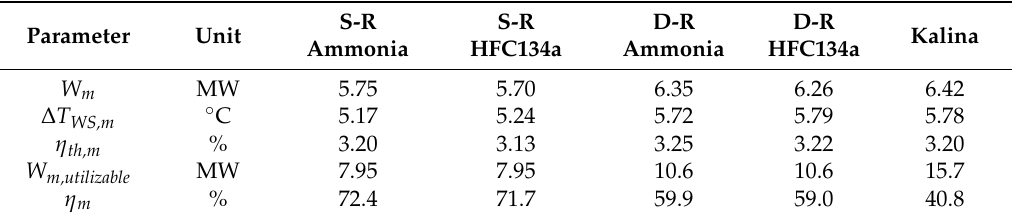
Figure 15. Relationship between the maximum power efficiency and the warm seawater temperature change. Table 1. Parameters at the maximum power output.